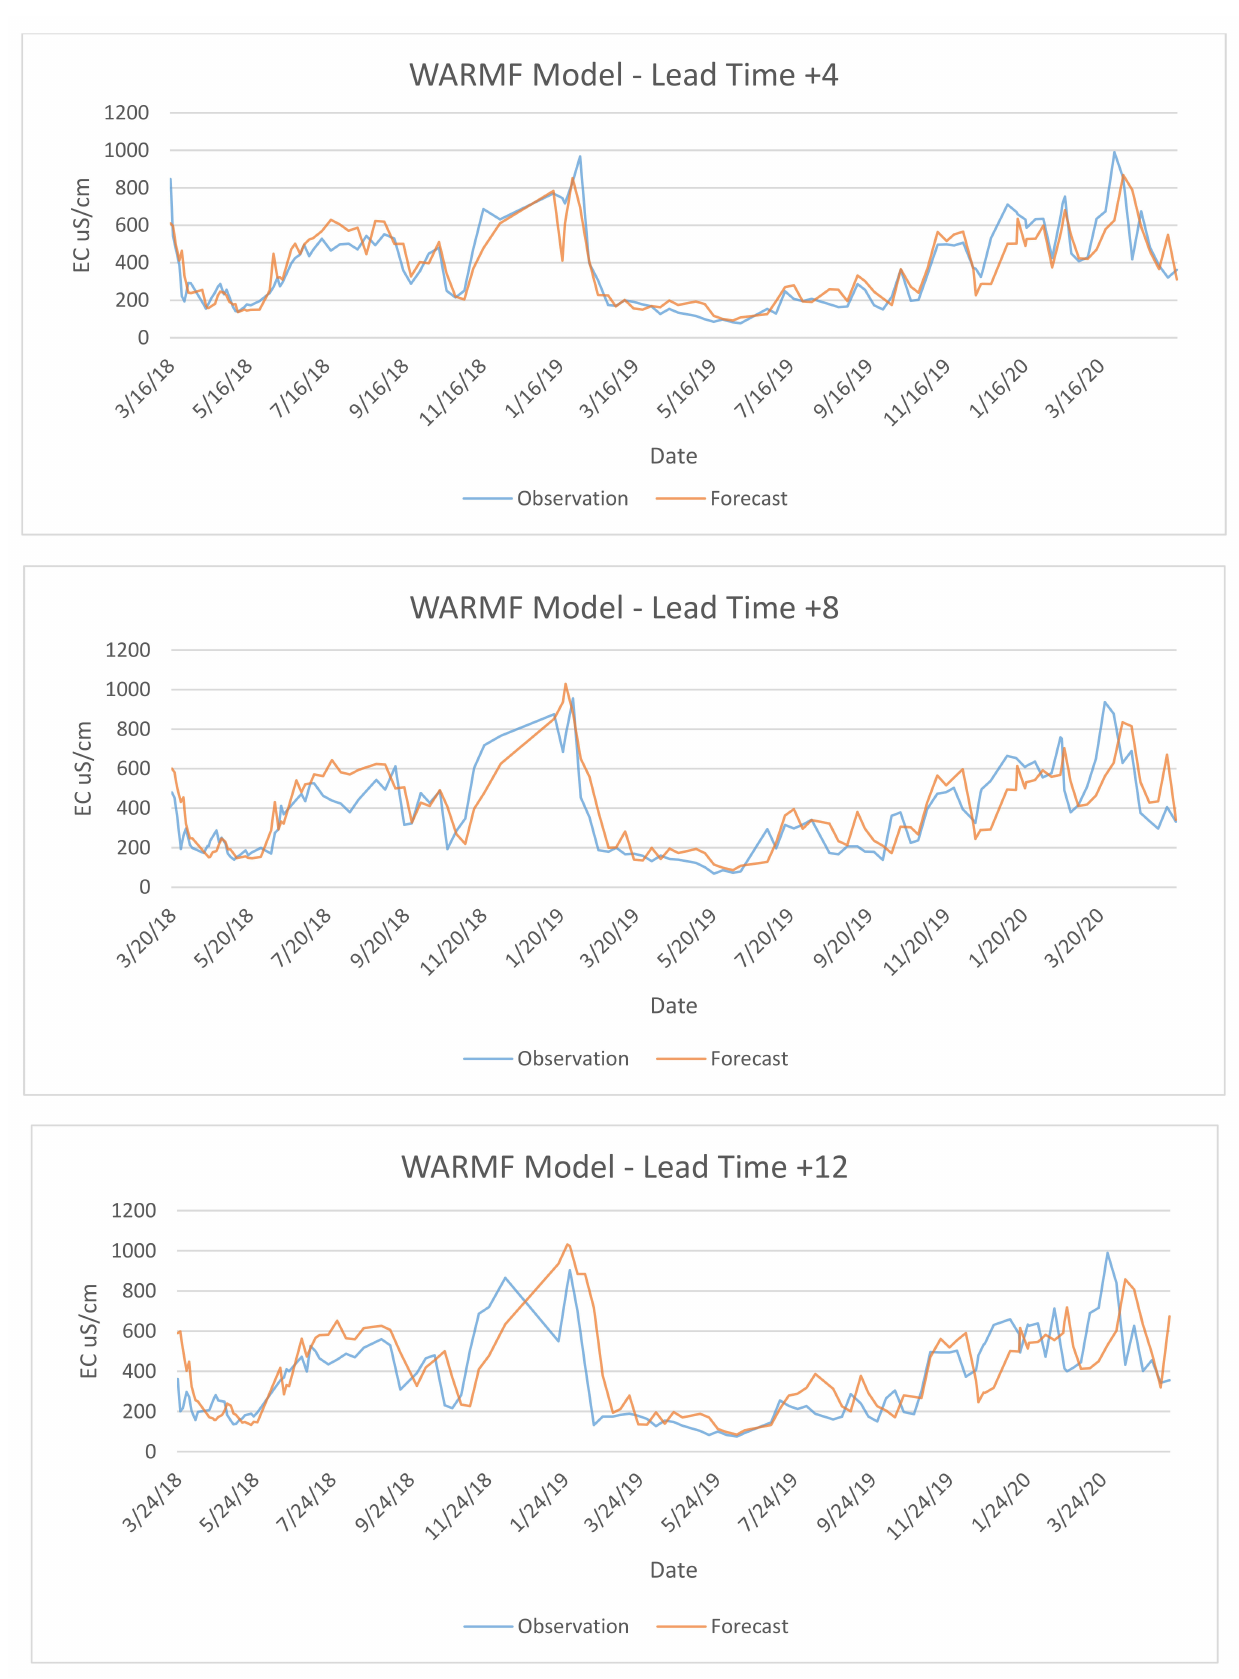
Figure 12. Comparison of WARMF model forecasts and observations of EC at various lead times for the period between